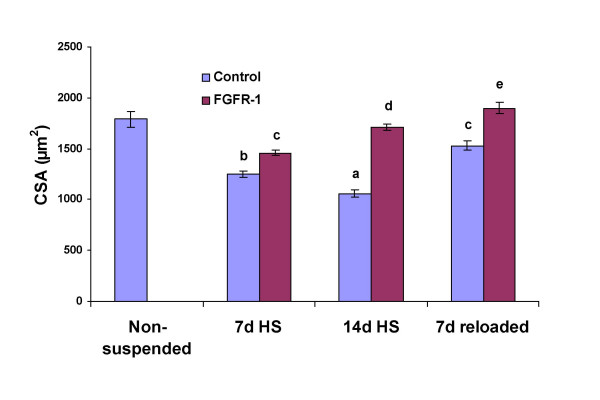
Overexpression of FGFR1 inhibits muscle atrophy. Cross-sectional area (CSA) of fibers from gastrocnemius muscles of mice transfected with either control (control) or FGFR1 expression plasmid DNA (FGFR1), subjected to hindlimb suspension for 7 d (7 d HS), 14 d (14 d HS), reloaded for 7 d after 7 d of hindlimb suspension (7 d reloaded), or non-suspended controls (NS). Means (±SEM) bearing different letters differ significantly (P < 0.05).